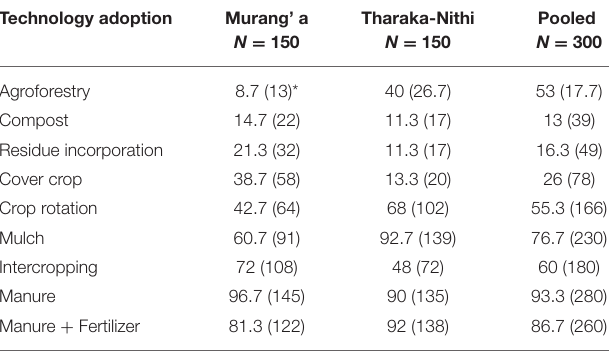
TABLE 4 | Adoption percentages of selected organic-based technologies in Murang’a and Tharaka-Nithi counties. Technology adoption